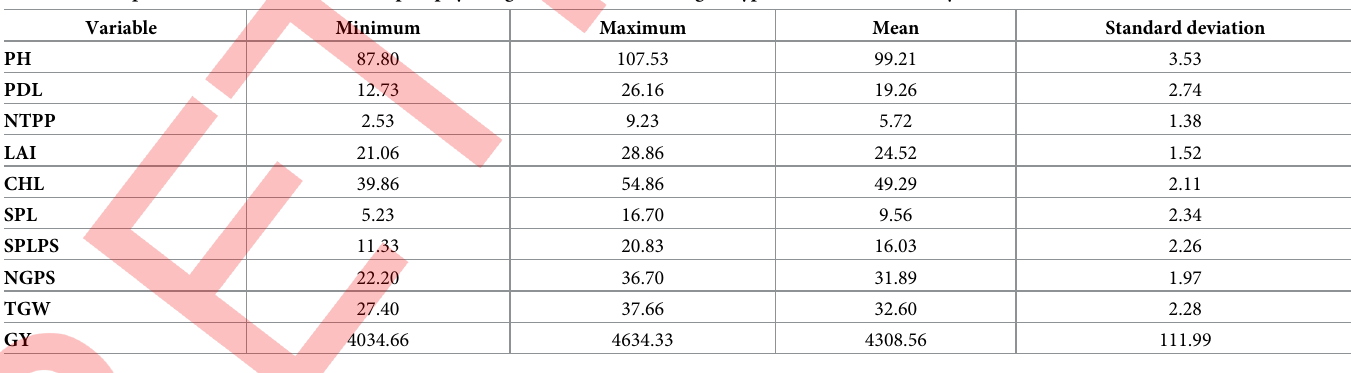
Table 6. Descriptive statistics for different morpho-physiological traits of 40 wheat genotypes included in the study.